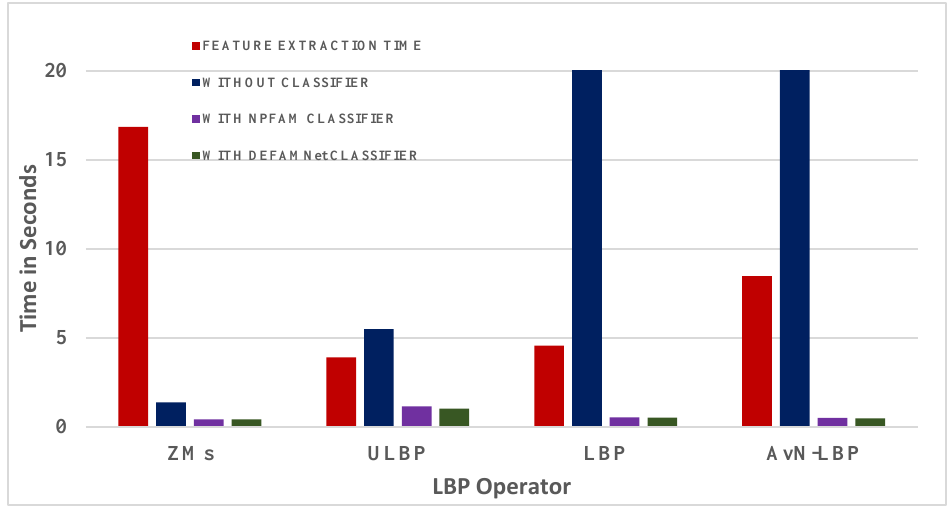
Figure 11. Comparison of total CPU Elapsed time and Retrieval time in seconds for LBP, ULBP, LDEP, ZMs, and the proposed LBP/VAR-based feature descriptors over OASIS-MRI databases.